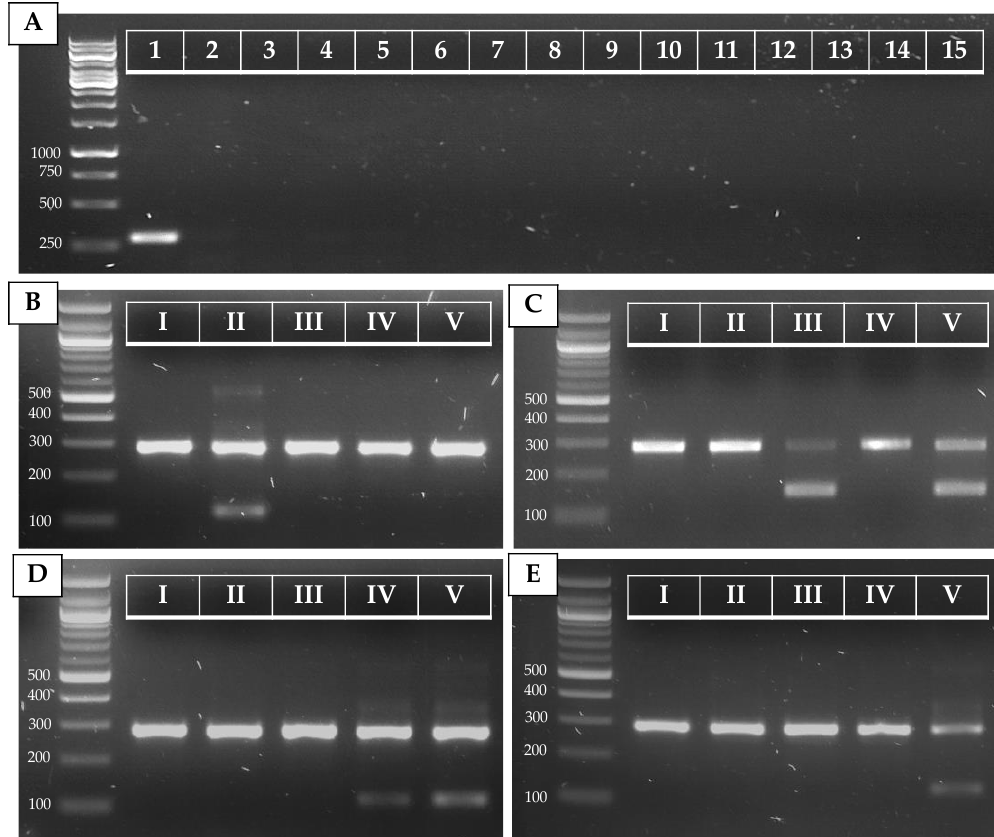
Figure 2. PCR results for C. auris ( A ) and C. auris clade ( B – E ) identification. ( A ) Simplex PCR of the ITS1 – ITS_CauR primer pair at 78 °C Ta on 20 ng of purified DNA of C. auris (1), C. haemulonii (2), C. duobushaemulonii (3), C. pseudohaemulonii (4), C. albicans (5), C. tropicalis (6), C. parapsilosis (7), C. glabrata (8), C. lusitaniae (9), C. orthopsilosis (10), C. metapsilosis (11), C. sake (12), C. dubliniensis (13), C. krusei (14), and S. cerevisiae (15). ( B – E ) Duplex PCR of the ITS1 – ITS_Cau_R and ITS1 – ITS_CauCII_R ( B ), RHA1 _CauCIII/V_F – RHA1 _CauCIII/V_R ( C ), ITS1 – ITS_CauCIV/V_R ( D ), and ITS1 – ITS_CauCV_R ( E ) primer pairs at 68 °C Ta on 20 ng of purified DNA of C. auris B8441 (I), B11220 (II), B11221 (III), B11244 (IV), and B18474 (V), which are reference strains from clades I to V, respectively.